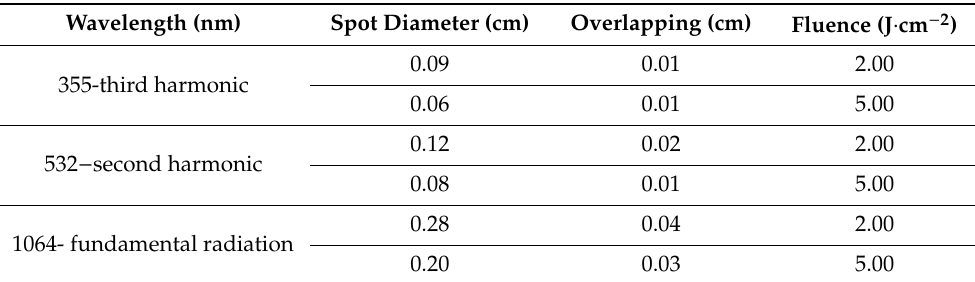
Table 1. Laser parameters used in the treatments with a Q-Switched (QS) Nd:YAG working at 355 nm, 532 nm, and 1064 nm to extract a SAB on the granite Vilach á